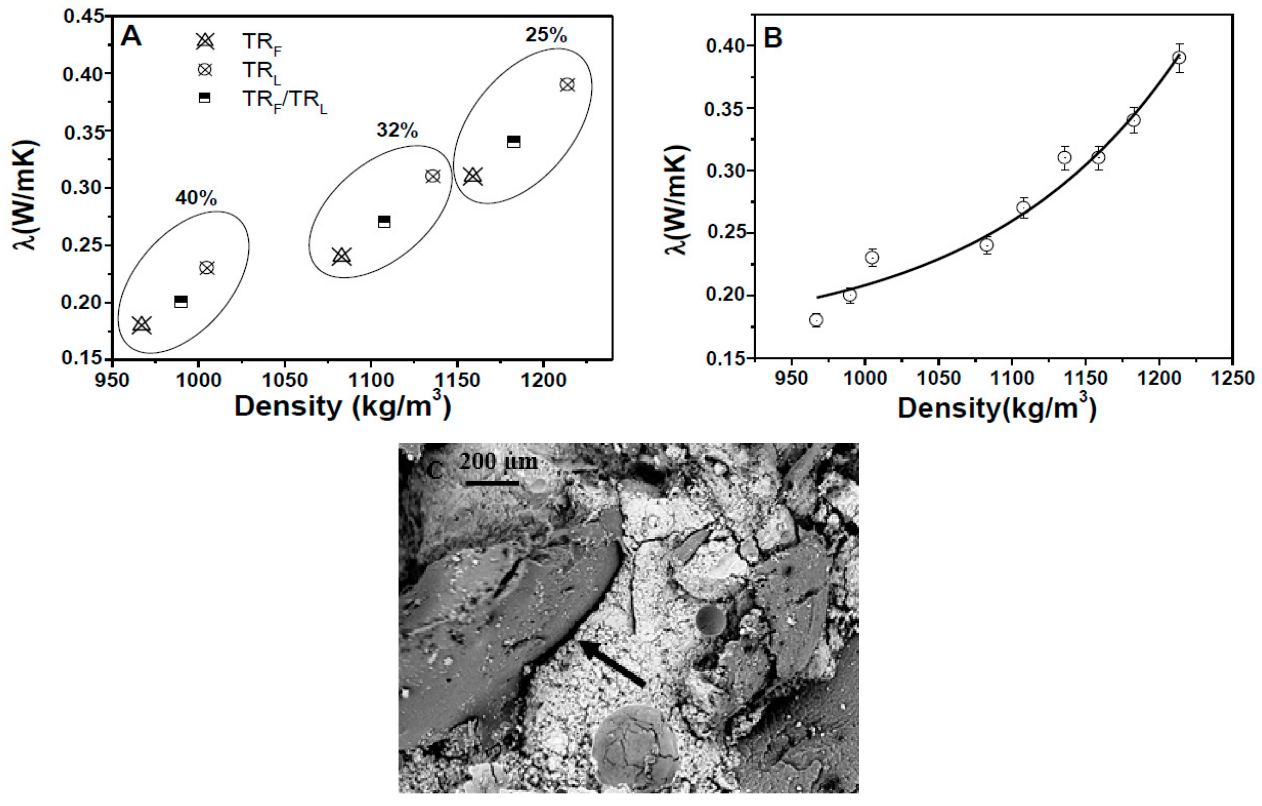
Figure 5. ( A ) Thermal conductivity of the TR specimens. The thermal conductivity of the sand reference was ≈ 2 W/mK. ( B ) Exponential increase of the thermal conductivity with the density increase. ( C ) SEM image of the cement/TR interface (the arrow represents the void at the interface).